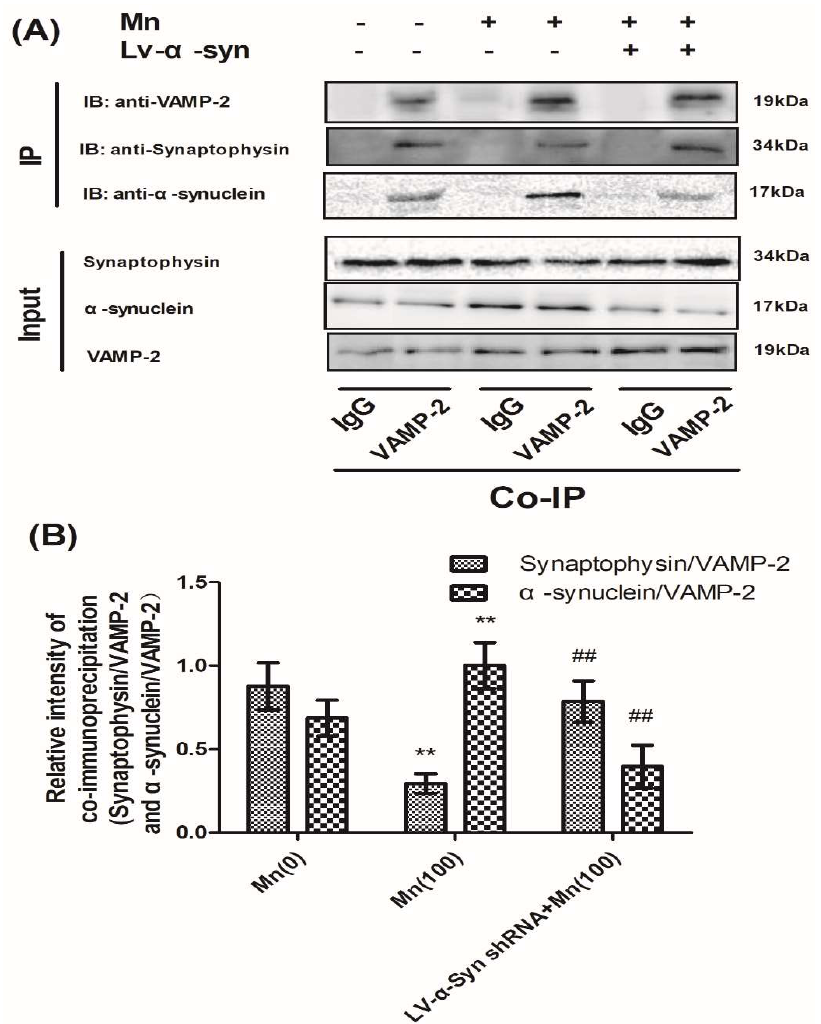
Figure 7. α -Syn shRNA reduced the protein interaction between VAMP-2 and α -Syn, but promoted the interaction between VAMP-2 and synaptophysin, during Mn exposure. ( A ) The immunoprecipitation products of VAMP-2 and α -Syn, and VAMP-2 and synaptophysin. ( B ) Semi-quantitative analysis of VAMP-2 and α -Syn, and VAMP-2 and synaptophysin. Expressions of synaptophysin and α -Syn were normalized with VAMP-2. Data represent mean ± SD, n = 4. ** p < 0.01 indicates significant differences from the controls; ## p < 0.01 indicates significant differences from 100 µ M Mn-treated group.